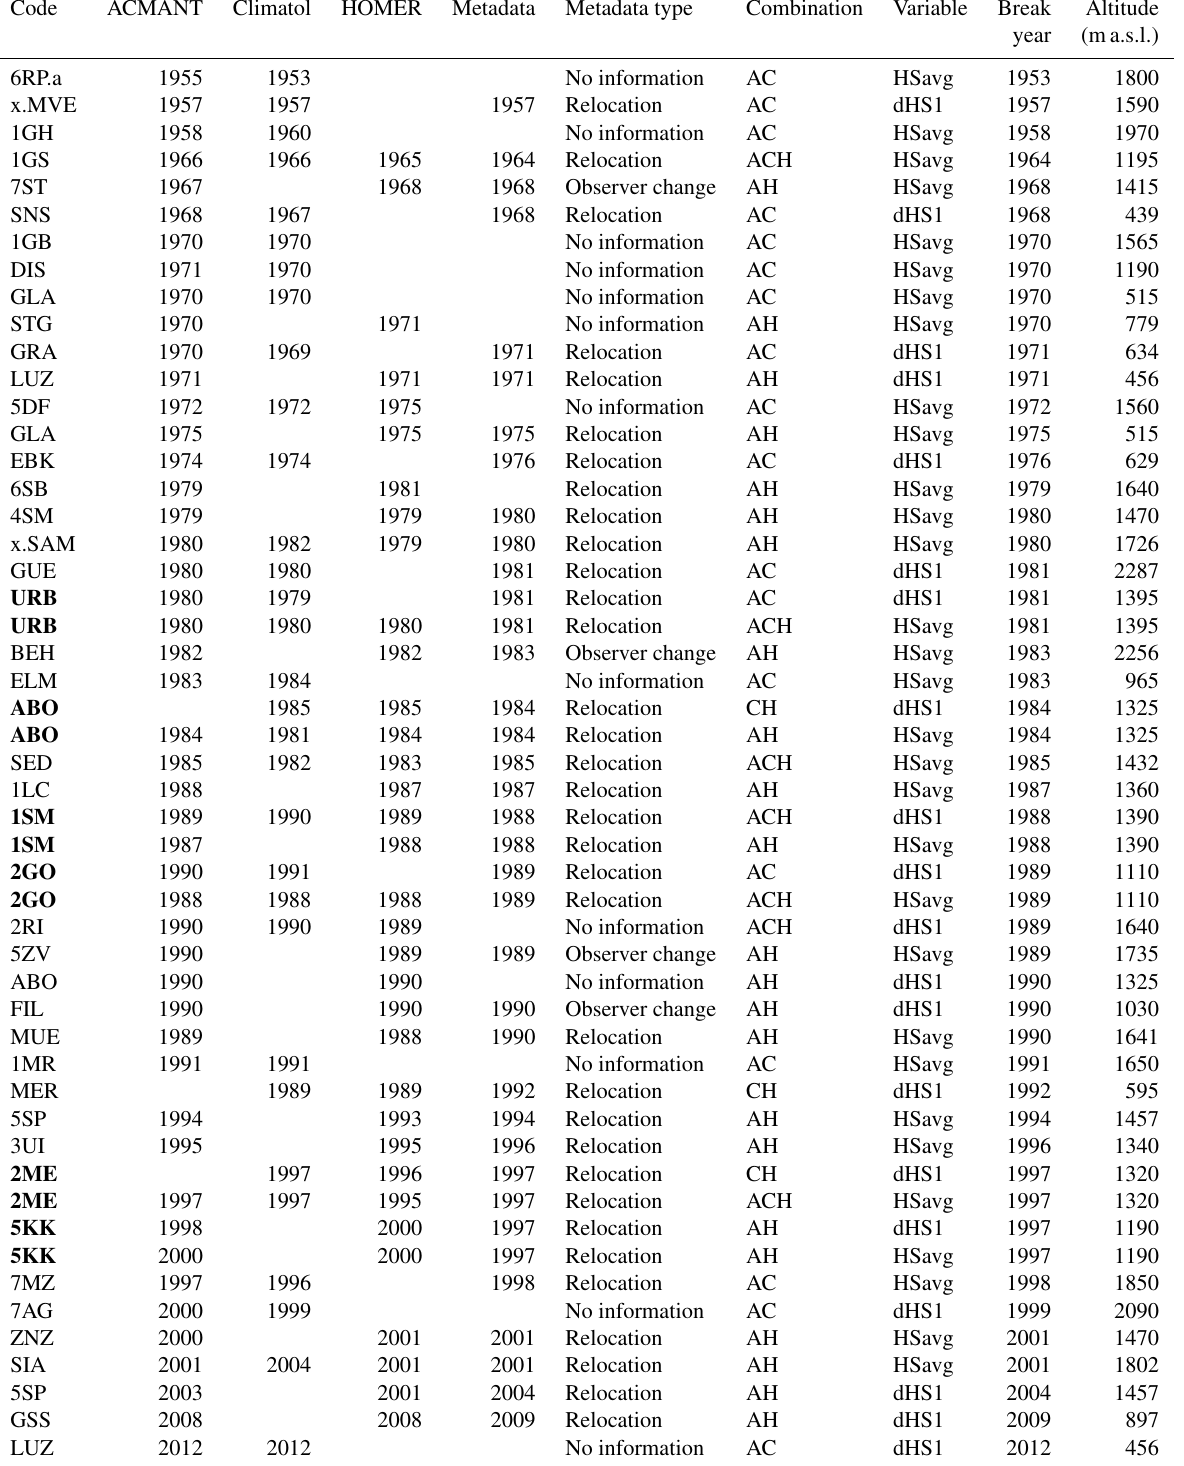
Table 3. List of valid break points concordantly identified in 184 investigated Swiss snow time series. Stations are ordered according to break year, and series with break points identified in both HSavg and dHS1 are marked bold. Combination code refers to ACMANT (A), Climatol (C), and HOMER